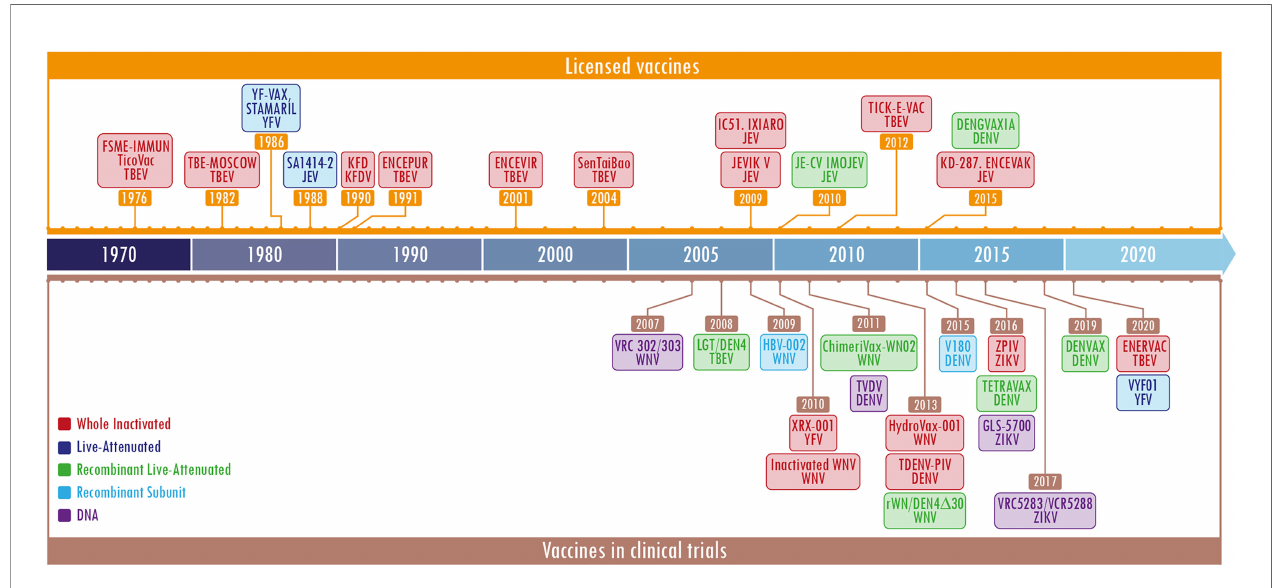
FIGURE 1 | Timeline of licensed fl avivirus vaccines and most representative candidate vaccines in clinical trials. The fi gure is divided into two sections, the upper one (in orange) shows the licensed vaccines and the lower one (in brown) depicts the vaccines in clinical trials. The different platforms employed for the developments are shown in speci fi c colors per label. Each label contains a fi rst or second line with the name of the licensed vaccine or the development, and the last one represents the virus against which the vaccine was designed. The color code is located in the lower section, the left side. The year shown is the licensing date or beginning of the clinical trial. The most representative vaccines under clinical trials were obtained at: https://clinicaltrials.gov/. The keywords used were fl avivirus and